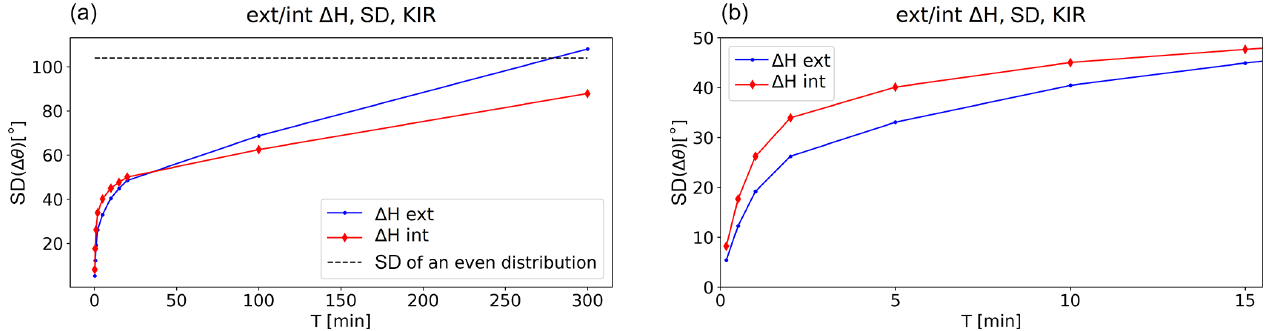
Figure 11. Standard deviations of (cid:49)θ for the external (blue line with dot markers) and internal (red line with diamond markers) (cid:49) H as a function of T at Kiruna (KIR). Threshold value for chosen events is | d (cid:49) H / d t | > 1nTs − 1 . On the left, T range is from 0 to 300min and a closeup on the first 15min is shown on the right.